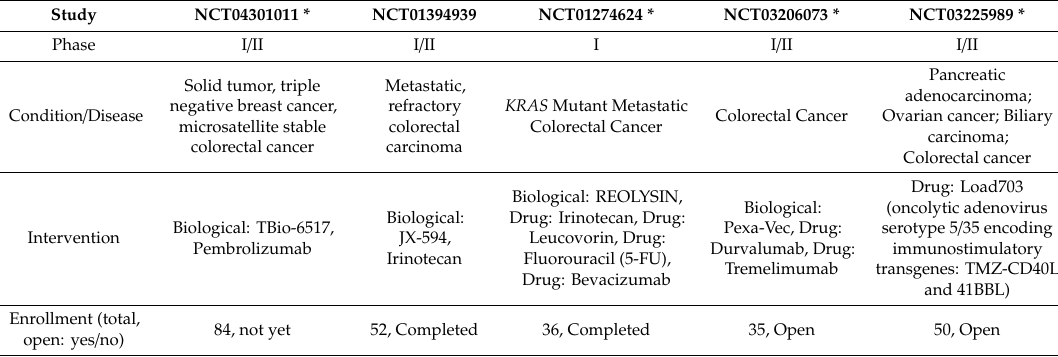
Table 4. Ongoing trials investigating oncolytic viruses in metastatic colorectal